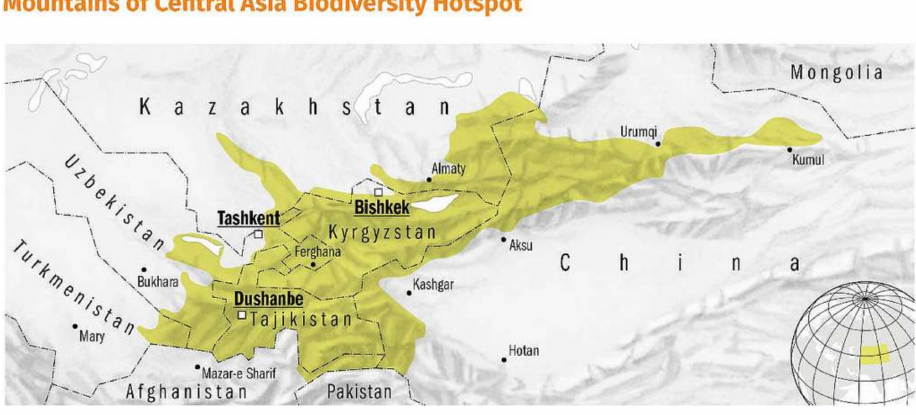
Figure 12. Mountains of Central Asia biodiversity hotspot [153]. Used with